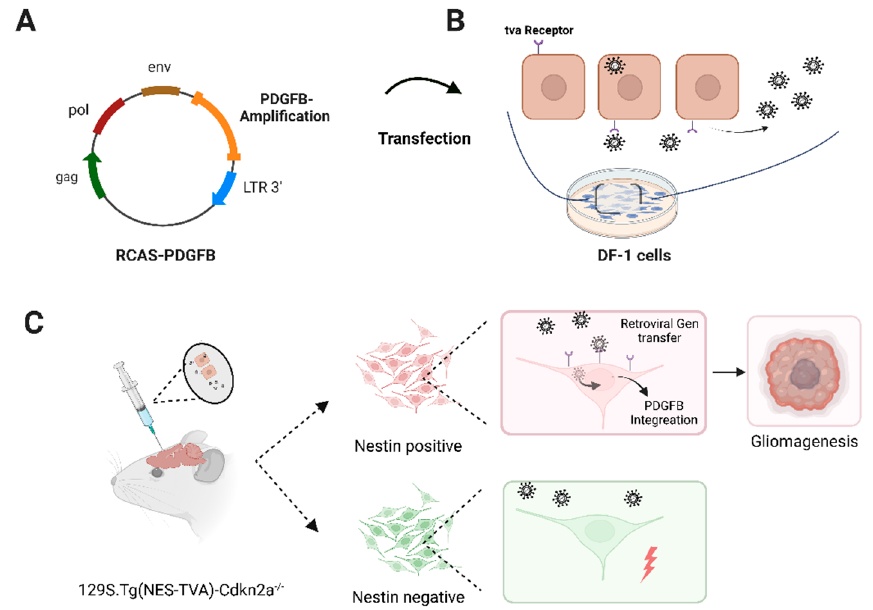
Figure 1. Schematic overview of the PDGFB-driven glioma mouse model using the RCAS-tva delivery system. ( A ) Schematic overview of the RCAS plasmid including a PDGFB amplification. This vector is transfected into DF-1 cells. ( B ) Viral replication takes place after cellular entry via tva receptor binding. ( C ) Implantation of 5 × 10 4 transfected DF-1 cells into genetic engineered animals. Tissue-dependent expression of the tva receptor is ensured by expression of tva controlled by the nestin promoter in mice. This leads to the infection of only the nestin-positive cell population (red). Subsequently, the PDGFB amplification is integrated retrogradely into the host genome. Together with the systemic deletion of the cell cycle regulator Cdkn2a, intracerebral tumor formation occurs. Created with BioRender.com.